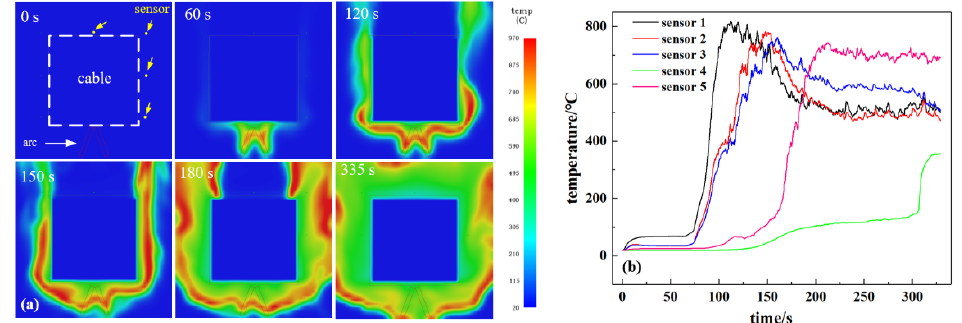
Figure 12. ( a ) The temporal and spatial distribution of the temperature during the ignition and flame propagation of the cable fire. ( b ) The temporal distribution of the temperature measured by the sensors.